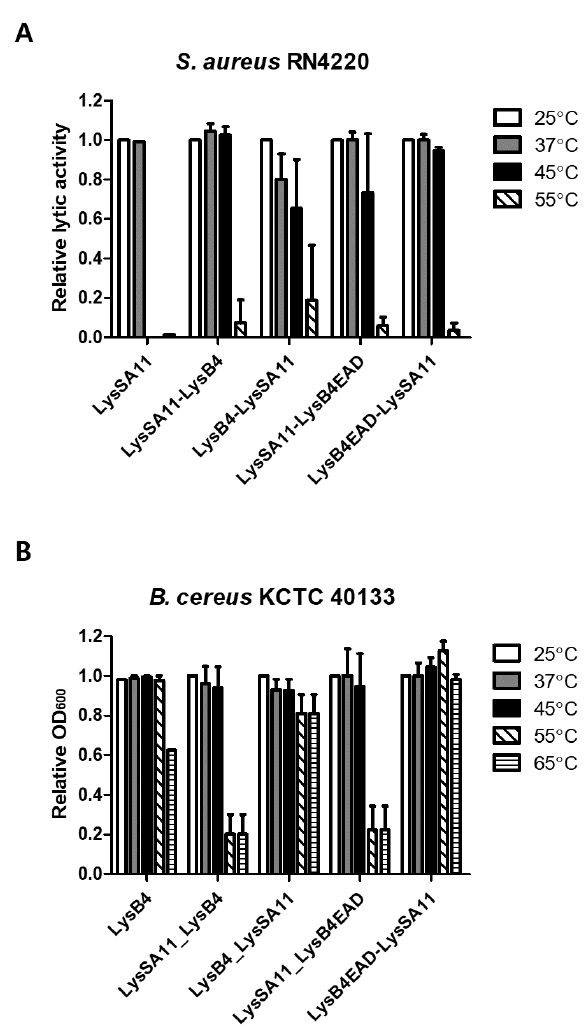
Figure 3. The thermal stability of the hybrid proteins. Equimolar concentrations (300 nM) of LysSA11, LysB4, LysSA11-LysB4, LysB4-LysSA11, LysSA11-LysB4EAD, and LysB4EAD-LysSA11 were incubated in reaction buffer at different temperatures for 30 min. Relative lytic activities against ( A ) S. aureus RN4220 and ( B ) B. cereus ATCC 21768 were calculated using the activity of the enzyme stored at 25 °C, which showed the maximal activity.